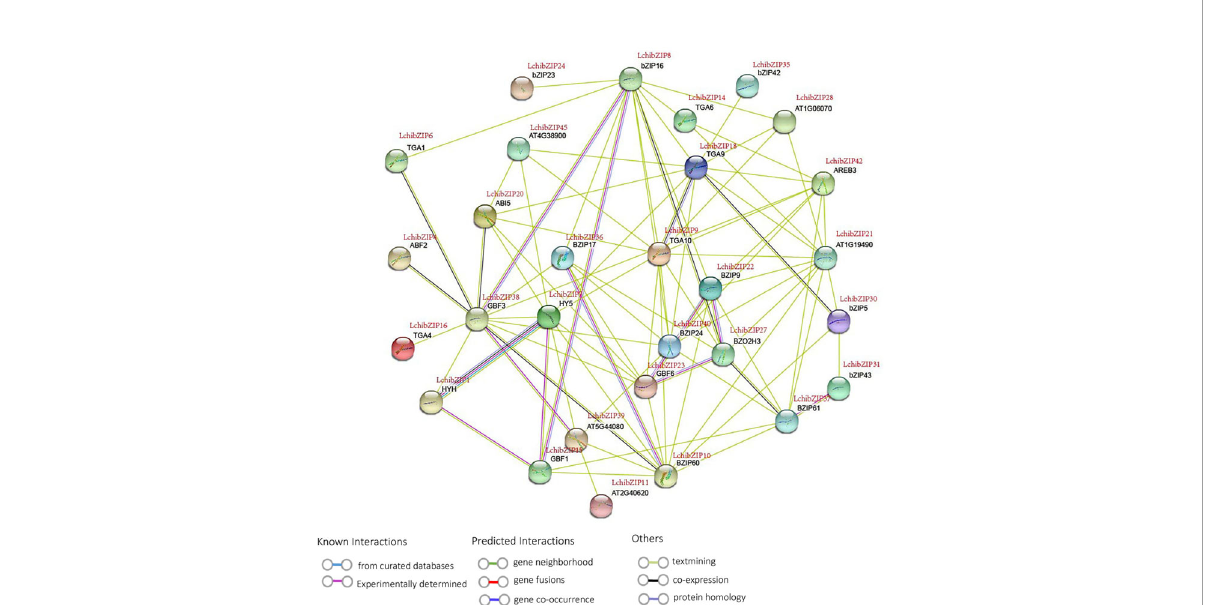
FIGURE 9 Protein interaction network of LchibZIPs from L.chinense . Purple lines indicate experimentally validated protein interactions; green lines indicate predicted protein interactions based on gene neighborhood; blue lines indicate predicted protein interactions based on gene co-occurrence; and black lines indicate protein